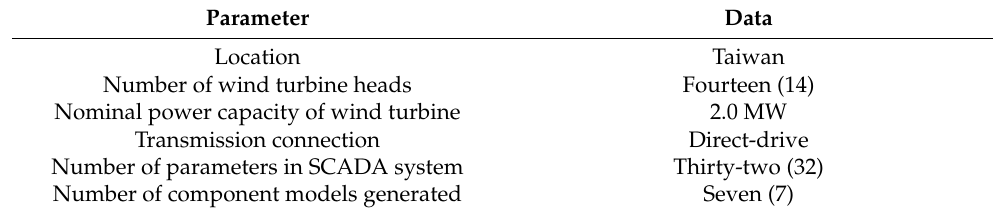
Table 1. General data of the wind turbine and SCADA system from the wind farm used in this study.